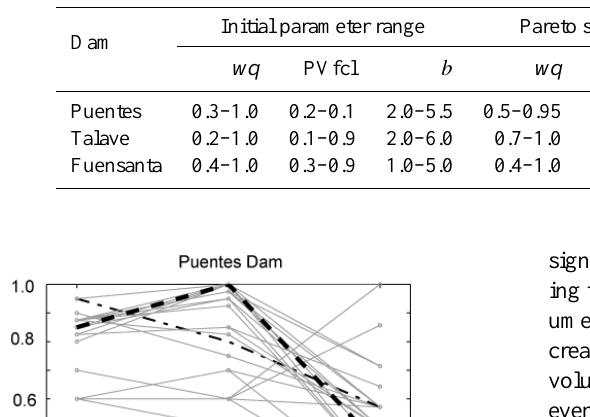
Table 5. Range of parameter values for all the parameter sets evaluated and non-dominated solutions; and parameter values corresponding to the balanced optimum solution.